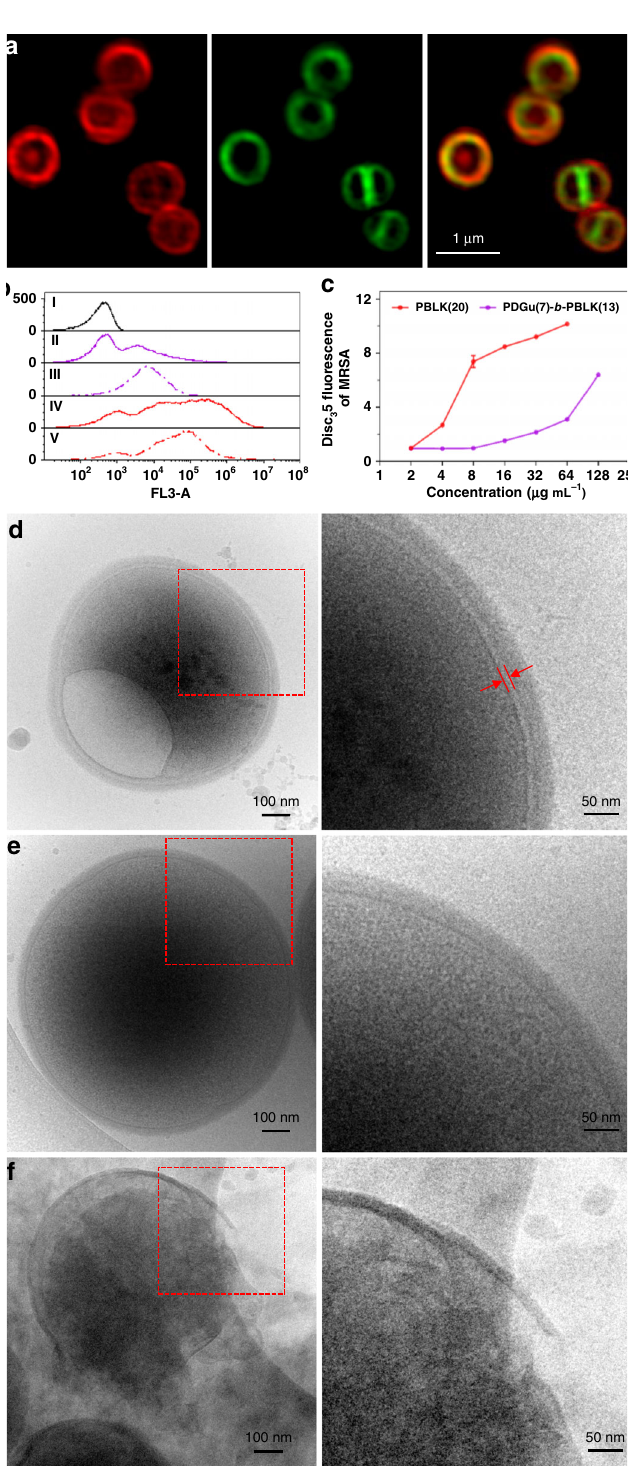
control, escape mutants resistant to the antibiotic cipro fl oxacin were easily selected (Supplementary Fig. 28). PDGu(7)- b -PBLK(13) targets the bacterial envelope . The structure of the cationic block co-beta-peptide suggests a possible